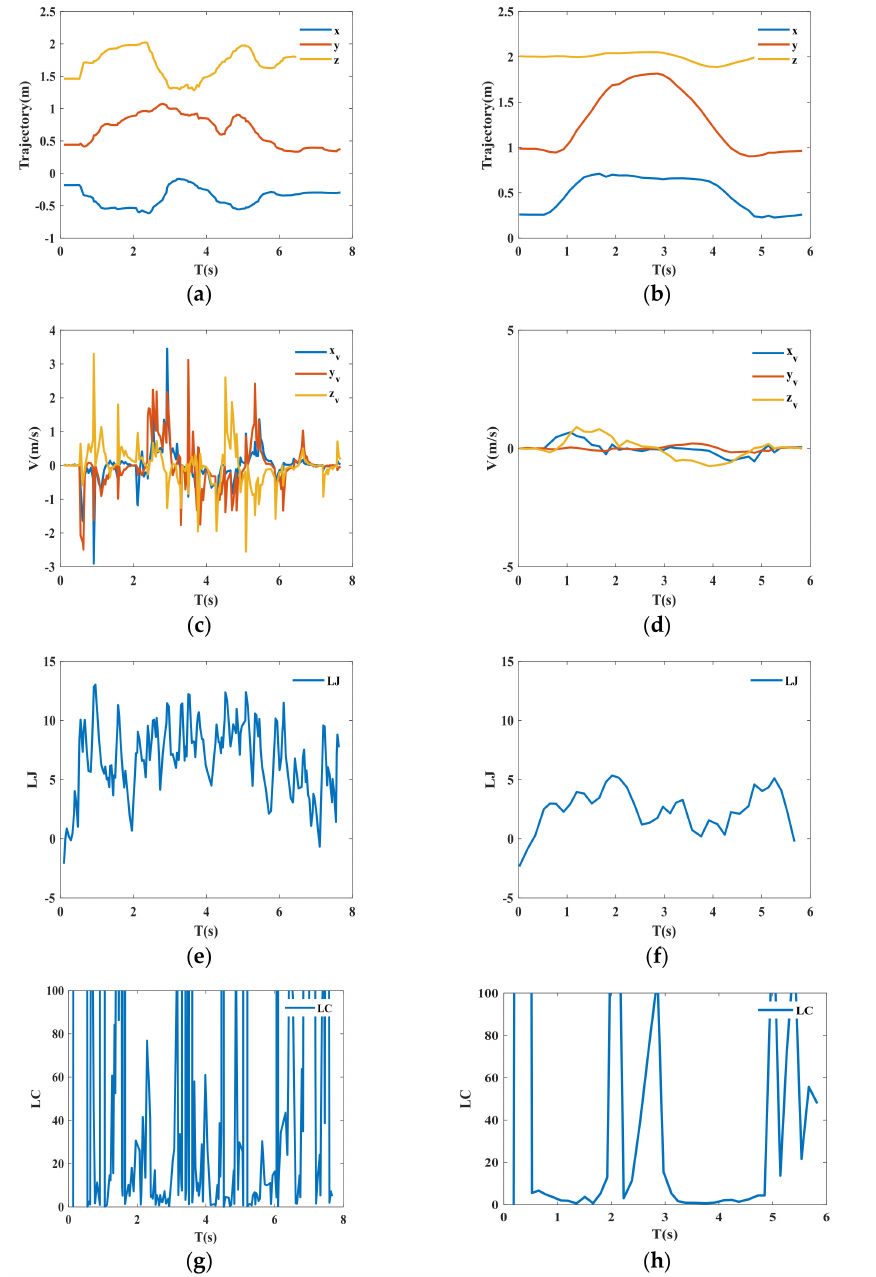
Figure 10. Performance indices: ( a ) motion trajectory of patient, ( b ) motion trajectory of healthy subject, ( c ) V of patient, ( d ) V of healthy subject, ( e ) LJ of patient, ( f ) LJ of healthy subject, ( g ) LC of patient ( h ) LC of healthy